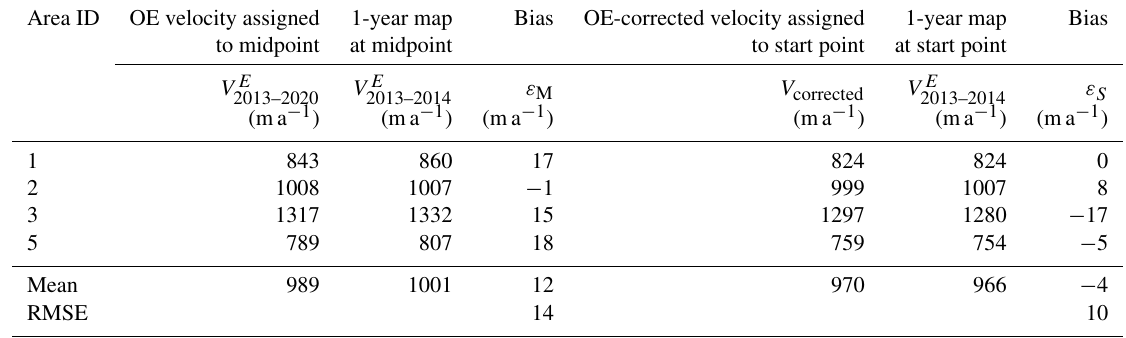
Table A5. Comparison of the proposed OE correction method with the midpoint method in Berthier et al. (2003). Area ID OE velocity assigned 1-year